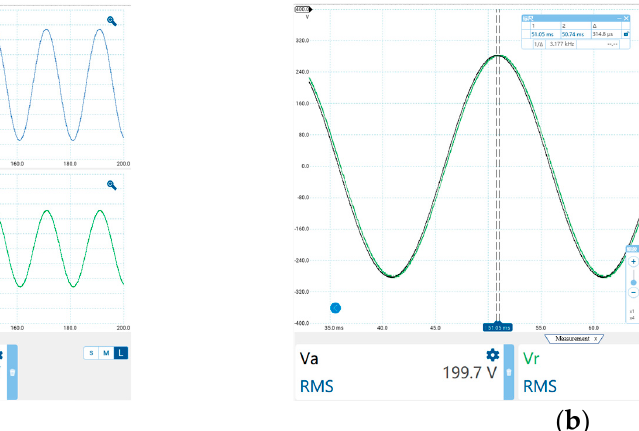
. Consistent with the accuracy testing experimental steps, the rec- orded output voltage is calculated using Equation (10). The reconstructed voltage and the actual output voltage are calculated using Equation (14) to obtain the relative error with and without interference sources. The error points with and without interference sources are plotted as shown in Figure 9. As can be seen from the figure, compared to the error of reconstructing the voltage without interference sources, the overall error offset with inter- ference sources is 0.25%. This indicates that the coaxial probe has good anti-interference ability and can effectively reduce interphase interference or surrounding coupling electric field interference. Figure 9. Reconstructed voltage and output voltage error characteristics with and without interfer- ence sources.